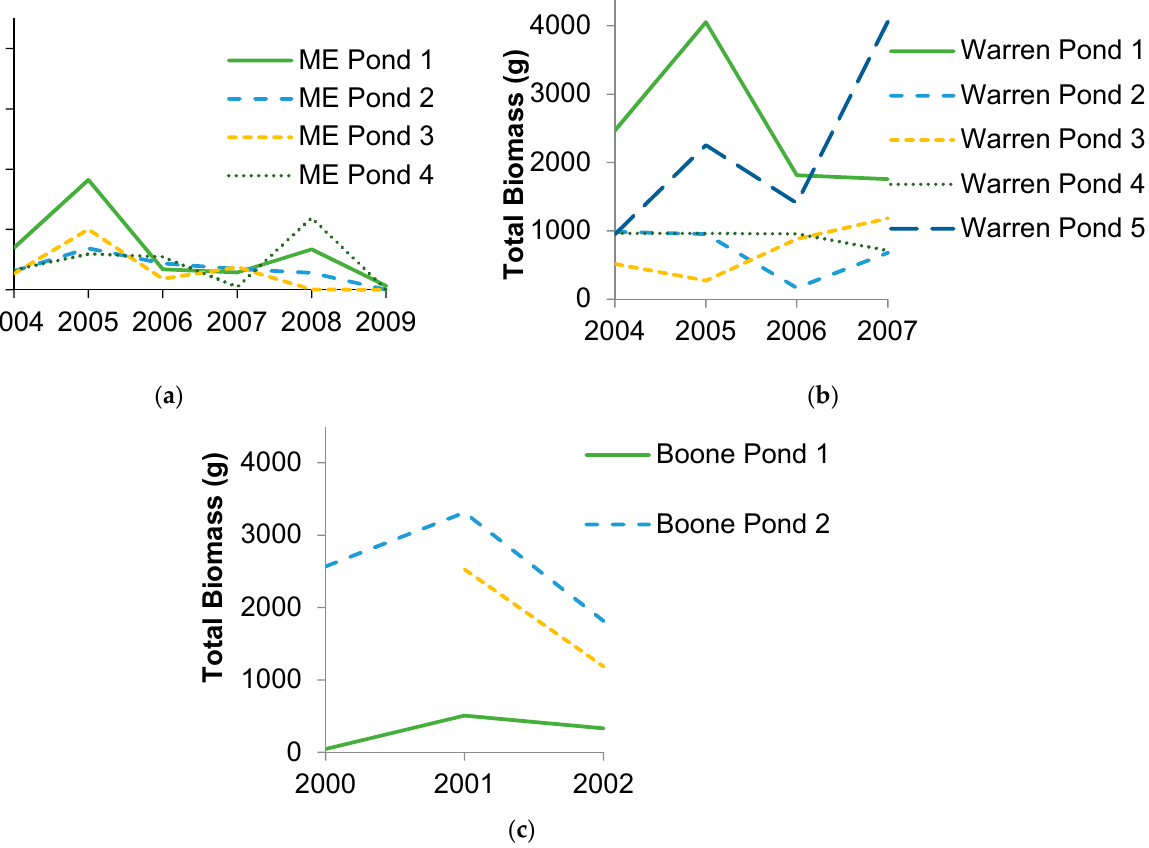
Figure 1. Total amphibian wet biomass export for ( a ) four ponds in Penobscot County, Maine (ME) over six years, ( b ) five ponds in Warren County, Missouri (DBCA) over four years, and ( c ) three ponds in Boone County, Missouri over two to three years (ponds 1 and 2: Baskett Wildlife Area, edge pond: Mark Twain National Forest).